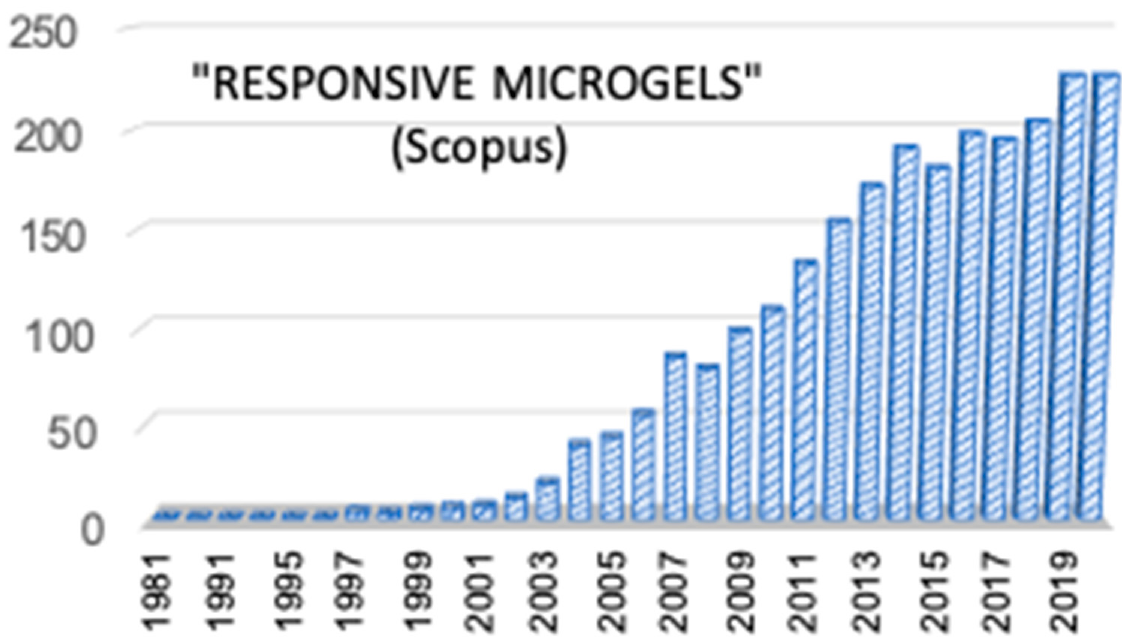
Figure 1. The evolution of the citations about responsive microgels up to 2020 are shown (source: Scopus).